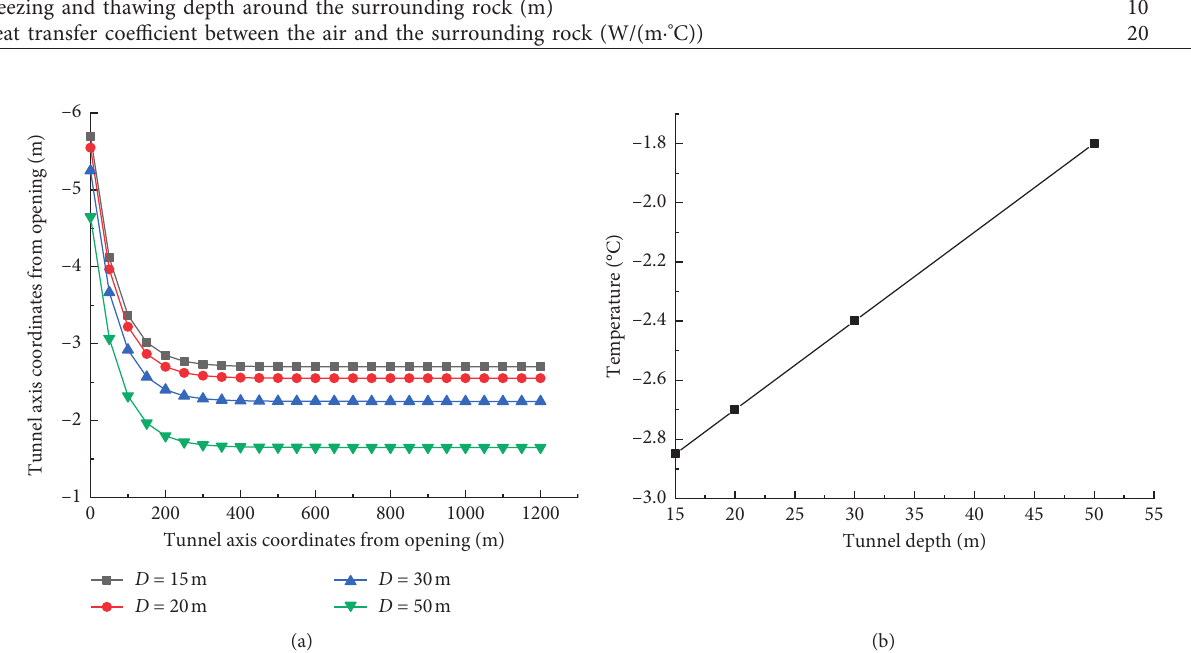
Figure 4: The annual air average temperature change curve under different tunnel depths: (a) annual longitudinal average temperature of the tunnel; (b) annual average air temperature of the same tunnel